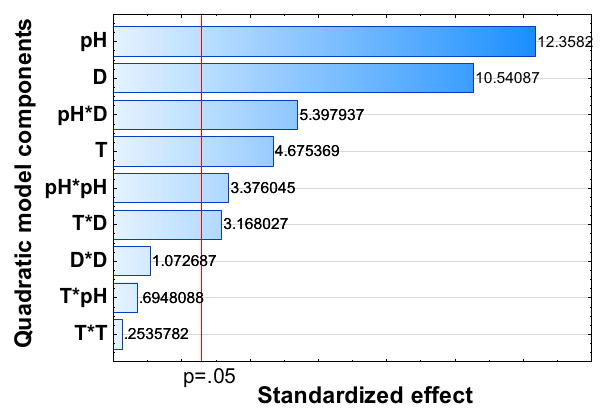
Fig. 4 Pareto chart showing the standardized effect of independent variables and their interaction on PO 43− removal